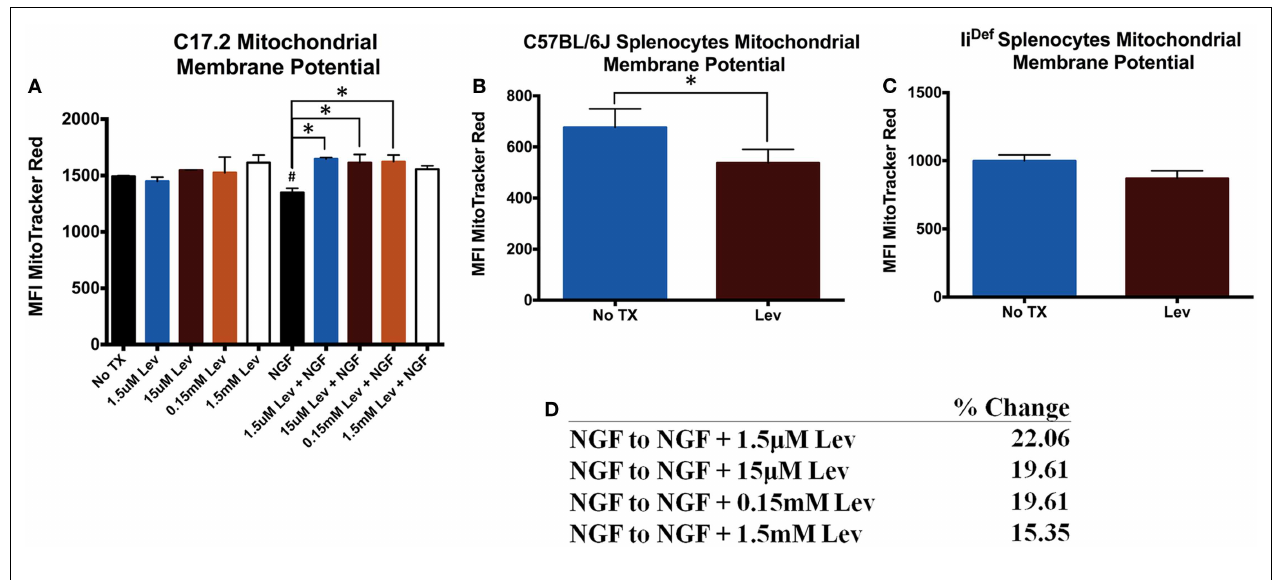
after treatment with or without 0.15mM Lev. (C) MFI Mitotracker Red in in Ii Def splenocytes 48h after treatment with or without 0.15mM Lev. (D) Table depicting percent change from NGF treatment alone, compared to NGF treatment in the presence of doses of levetiracetam. *Denotes a p -value <